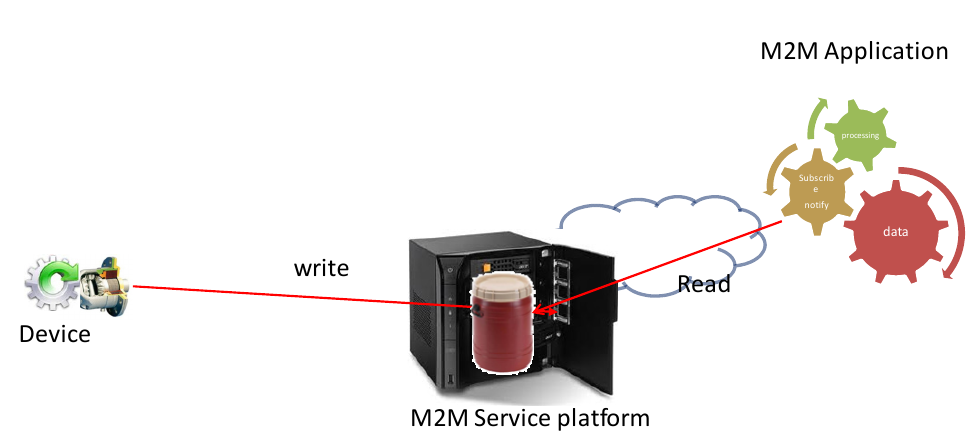
Figure 15. ETSI M2M Trust